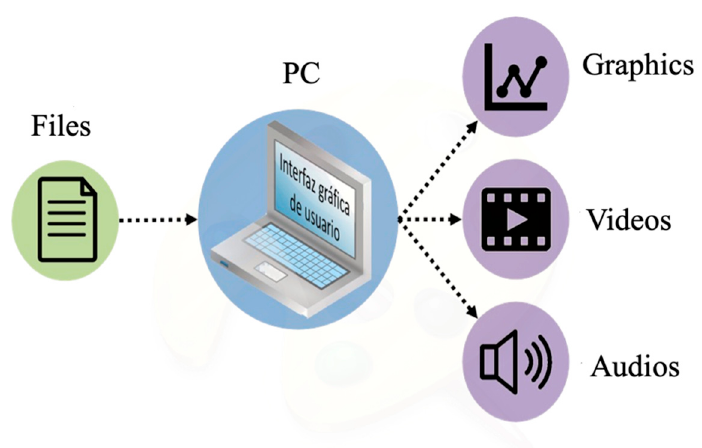
Figure 3. The scheme for processing the information.